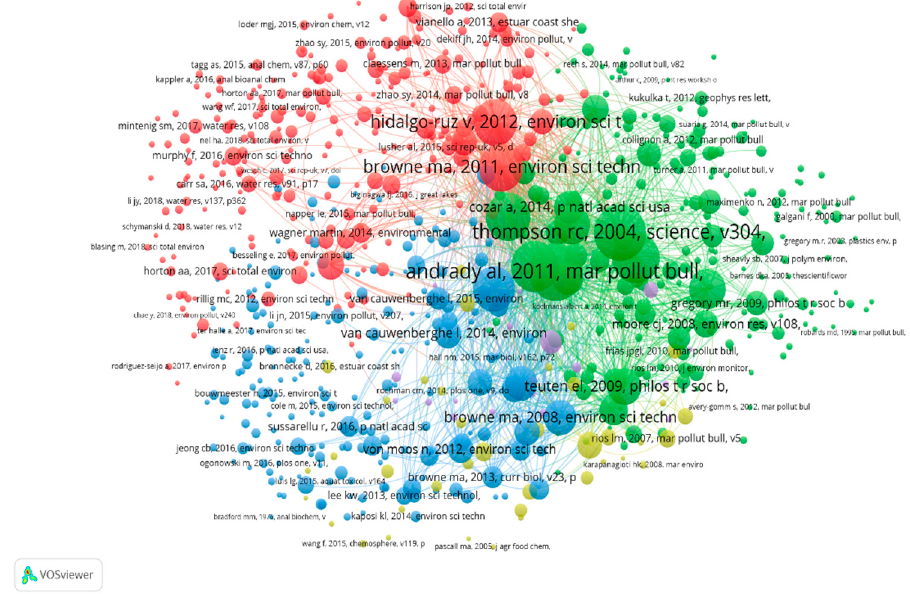
Figure 3. Co-citation network diagram of cited references from MPs articles cited a minimum of 30 times.